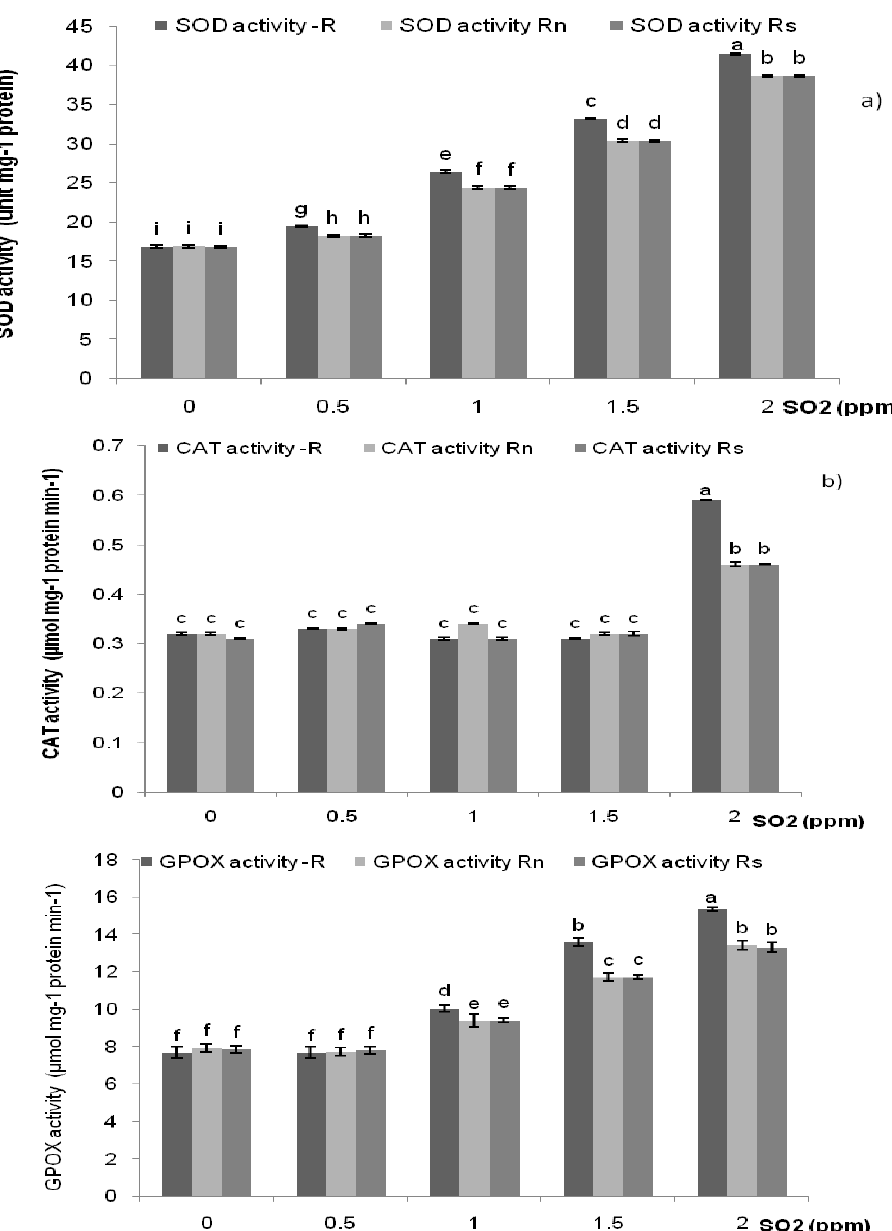
Fig 3. Interaction effect of bacterial inoculation and SO 2 pollutionon antioxidant activity of SOD (a), CAT (b) and GPOX (c) the leaves of alfalfa under SO 2 pollution in 45 days plants. Data are mean ± SE. Different letters indicate that the mean value is significantly different (p <